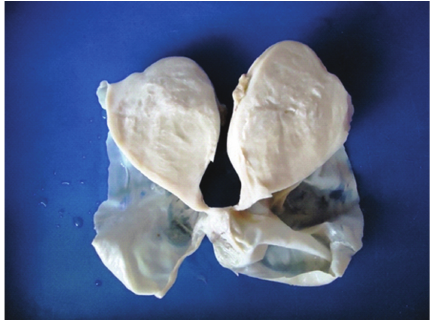
Figure 2: Cut section of the right ovarian tumour. Solid and cystic components are seen with clear demarcation.